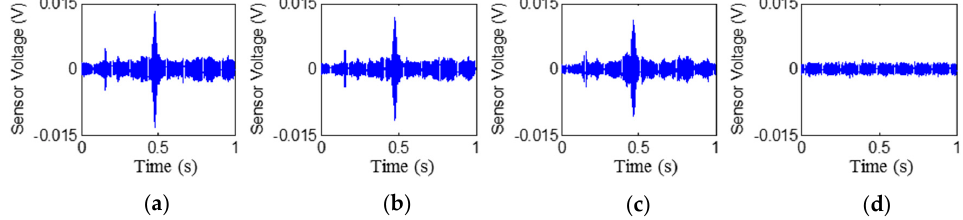
Figure 6. Signal received by PZT 2 (PZT1–PZT2 pair): Stage 0 to Stage 3 from left to the right. ( a ) Stage 0 ; ( b ) Stage 1; ( c ) Stage 2; ( d ) Stage 3.